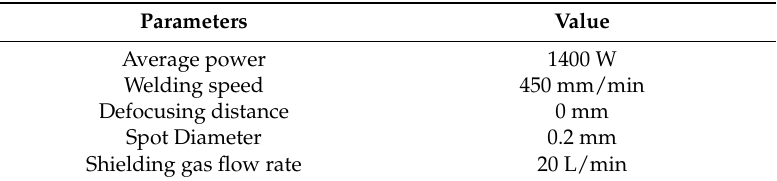
Table 2. Laser welding